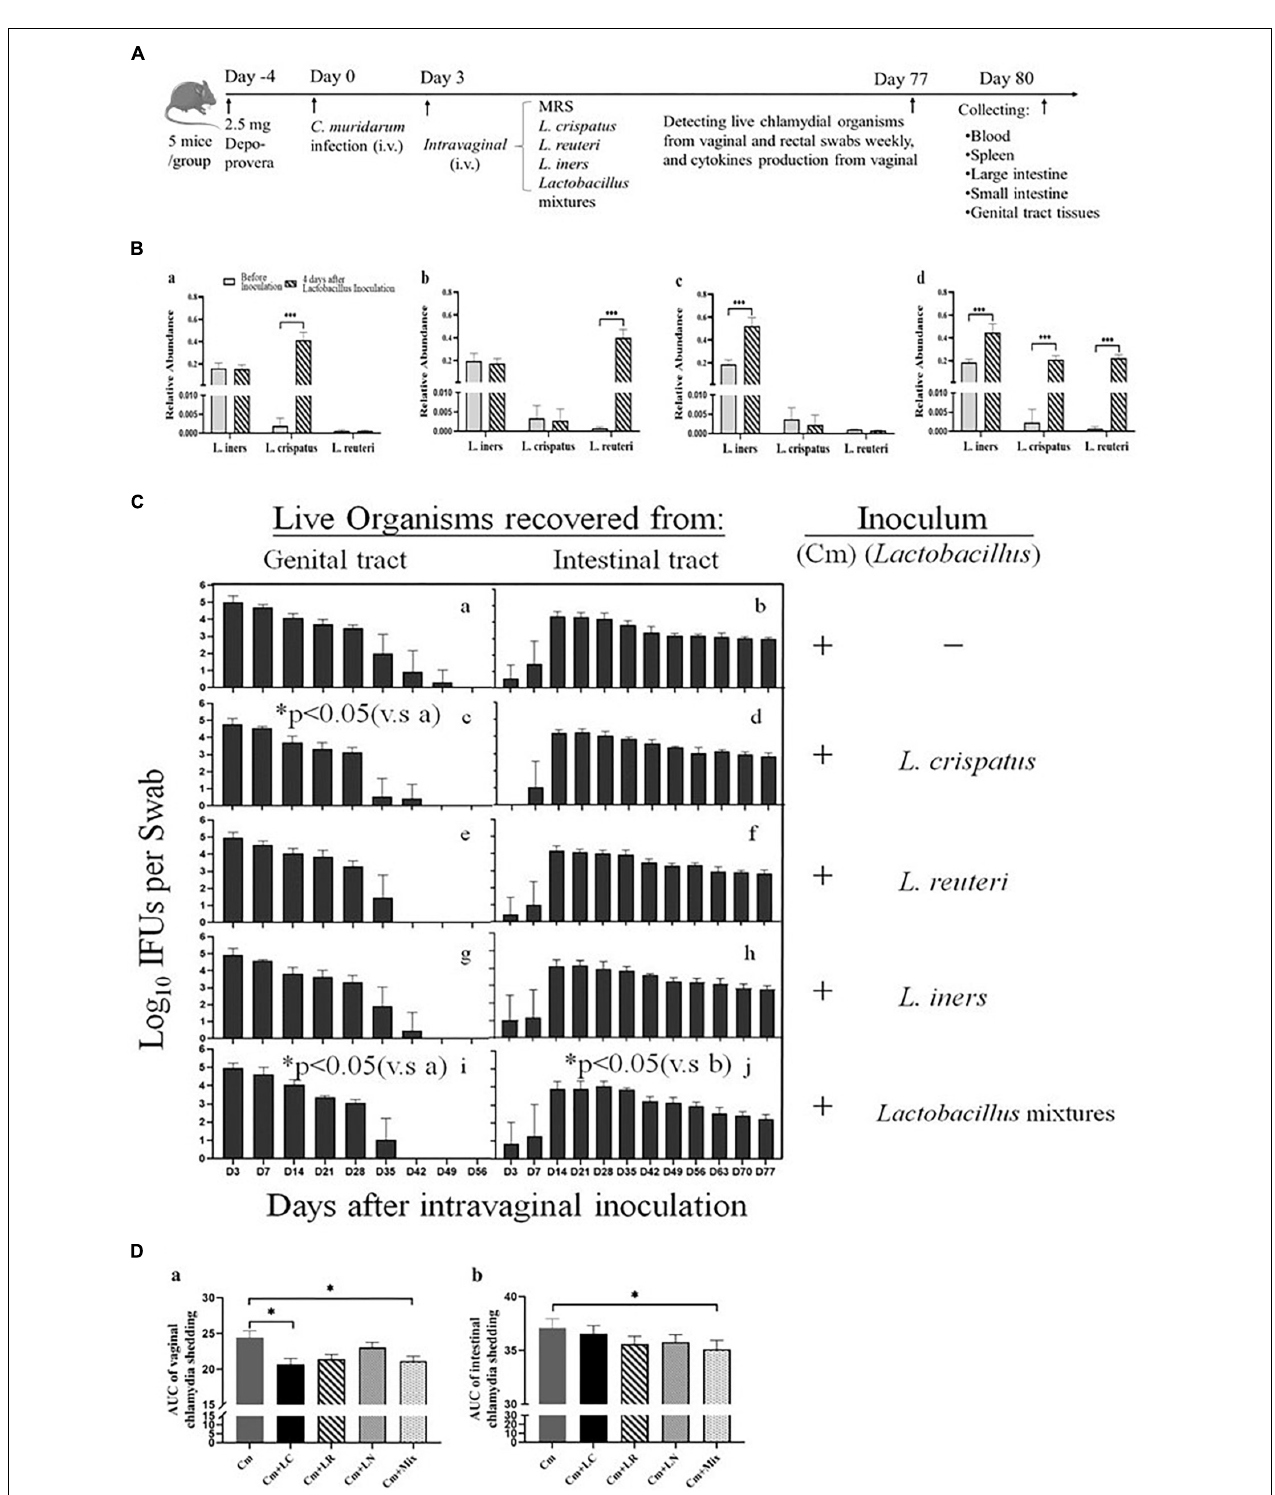
FIGURE 3 | Comparison of the live organism shedding from mice intravaginal inoculated with various lactobacilli after genital chlamydia infection. (A) Groups of female BALB/c mice were intravaginally inoculated with 2- × − 10 5 IFUs of C. muridarum EBs or SPG (control) alone. As indicated on top of the figure, the mice were given either an MRS medium (Cm), 15 µ L of 2- × − 10 9 CFU of L. crispatus (Cm + LC), L. reuteri (Cm + LR), L. iners (Cm + LN) or a mixture of these bacteria (Cm + Mix) at a ratio of 1:1:1 intravaginal inoculation 3 days after chlamydia infection. (B) Three days after the chlamydia infection, 15 µ L of 2- × − 10 9 CFU